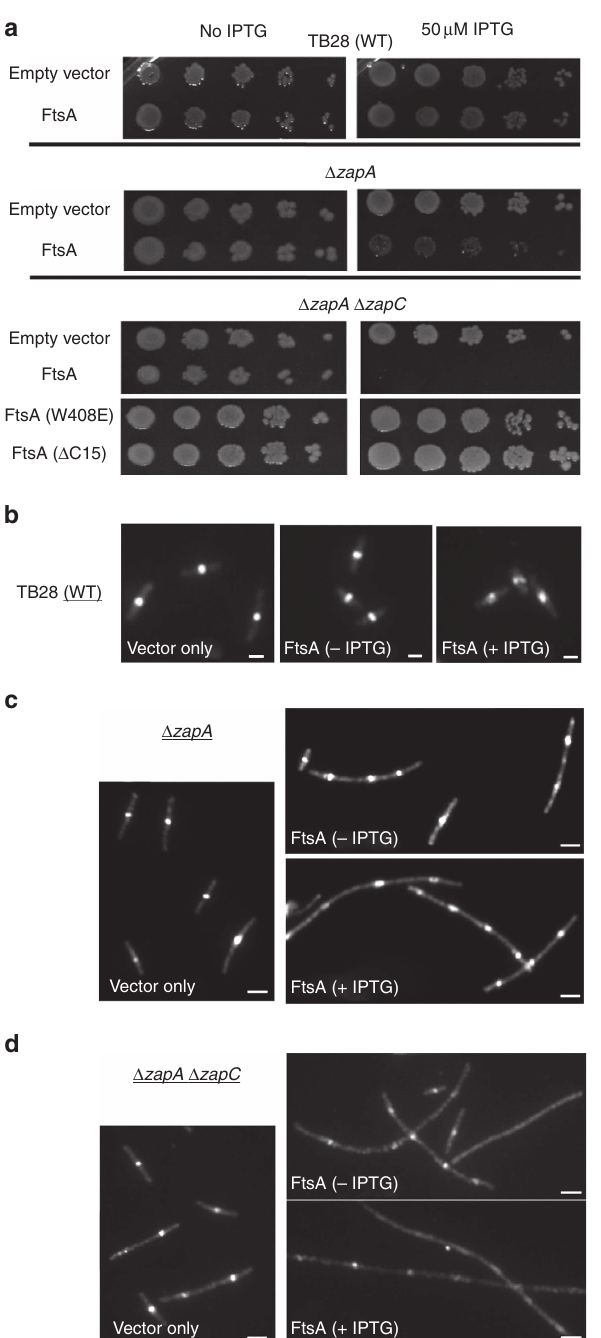
Figure 2 | Excess FtsA exacerbates the loss of zapA / zapC. ( a ) Spot dilutions of TB28, D zapA and D zapA D zapC cells transformed with pDSW210F, pDSW210F-FtsA, pDSW210F-FtsA(W408E) or pDSW210F-FtsA( D C15) and induced with 0 or 50 m M IPTG. ( b ) Immunofluorescence microscopy (IFM) of FtsZ in TB28 cells transformed with pDSW210F vector, uninduced or induced pDSW210F-FtsA. ( c ) IFM of FtsZ in D zapA and ( d ) D zapA D zapC cells transformed with indicated uninduced ( (cid:2) IPTG) or induced ( þ IPTG) pDSW210F constructs. Scale bars, 2 m m.